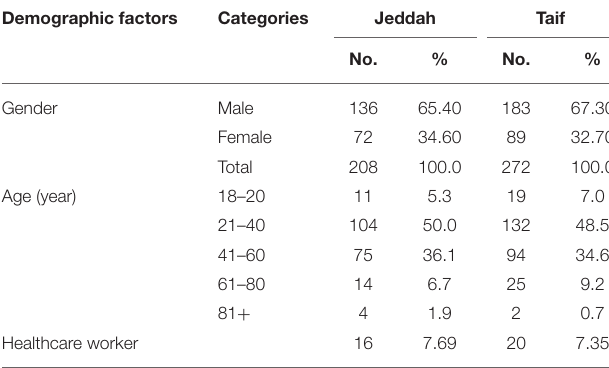
TABLE 6 | Demographic data of Jeddah and Taif COVID-19